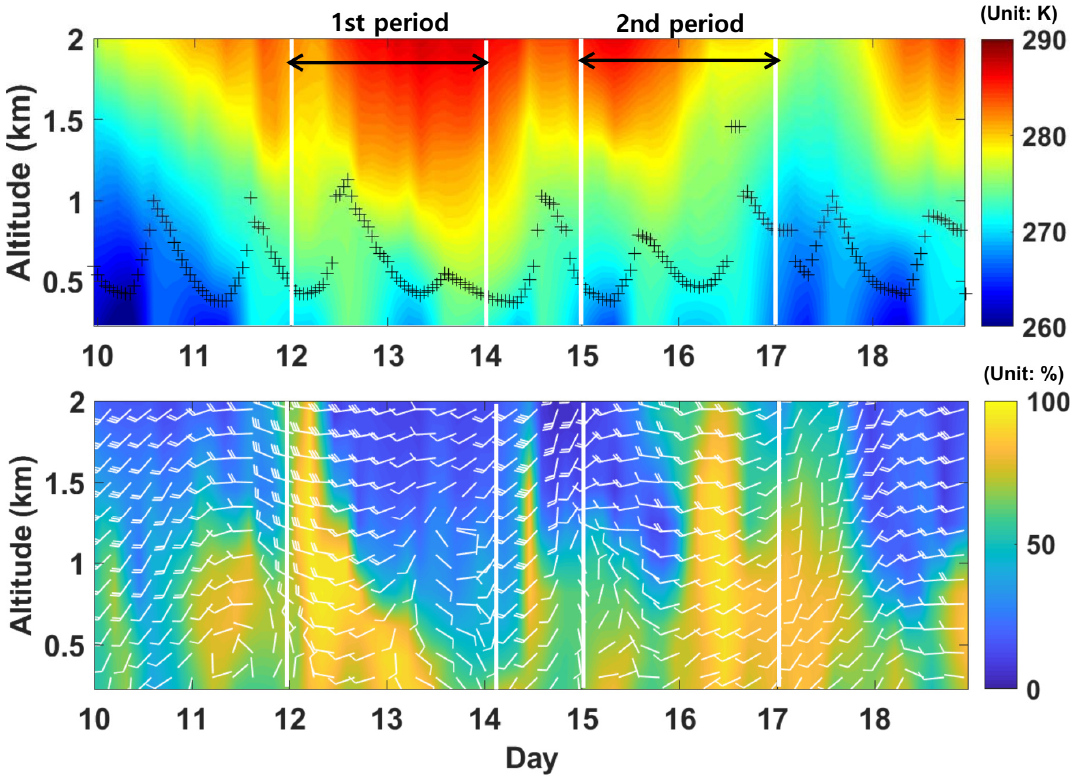
Figure 6. Time series of vertical distribution of domain-averaged potential temperature (upper panel) and relative humidity (bottom panel) using LDAPS. Cross markers in upper panel indicate the boundary layer height based on the Heffter’s method. Wind flags in the lower panel represent horizontal wind direction and wind speed (unit: m/s).